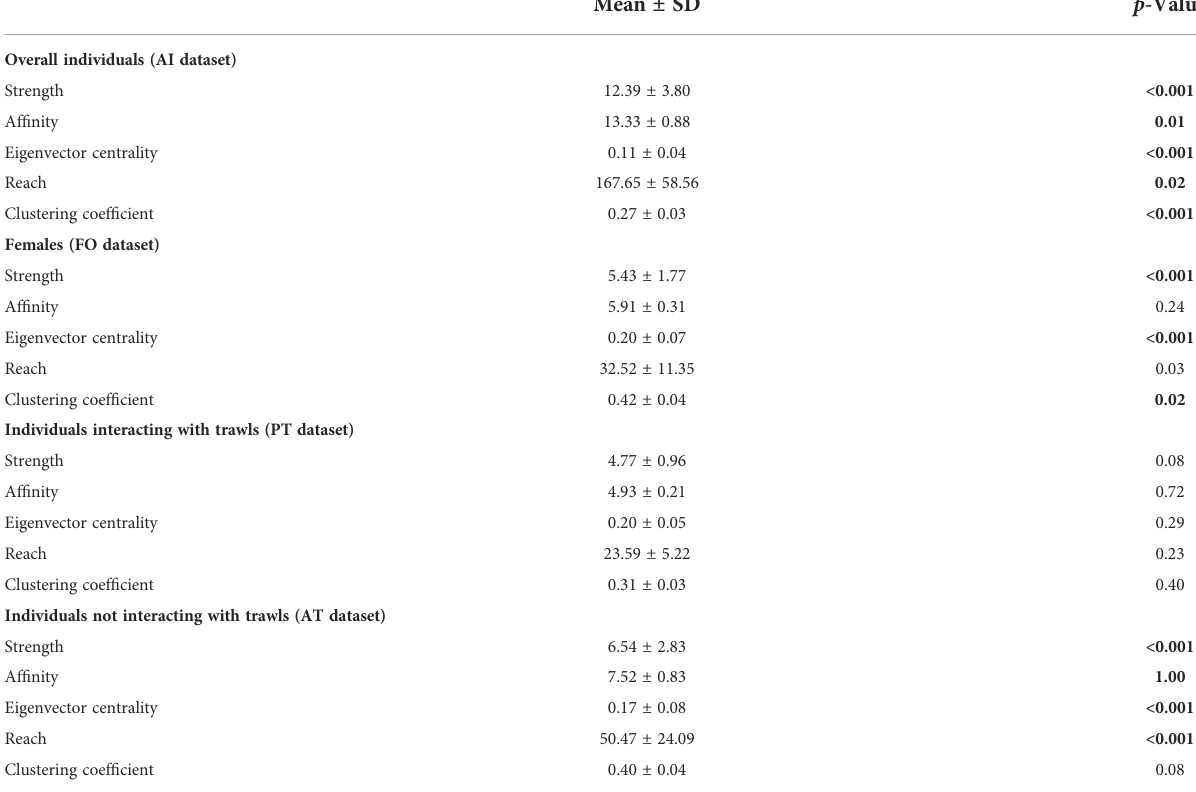
TABLE 2 Network metrics for the different groups of individuals considered in this